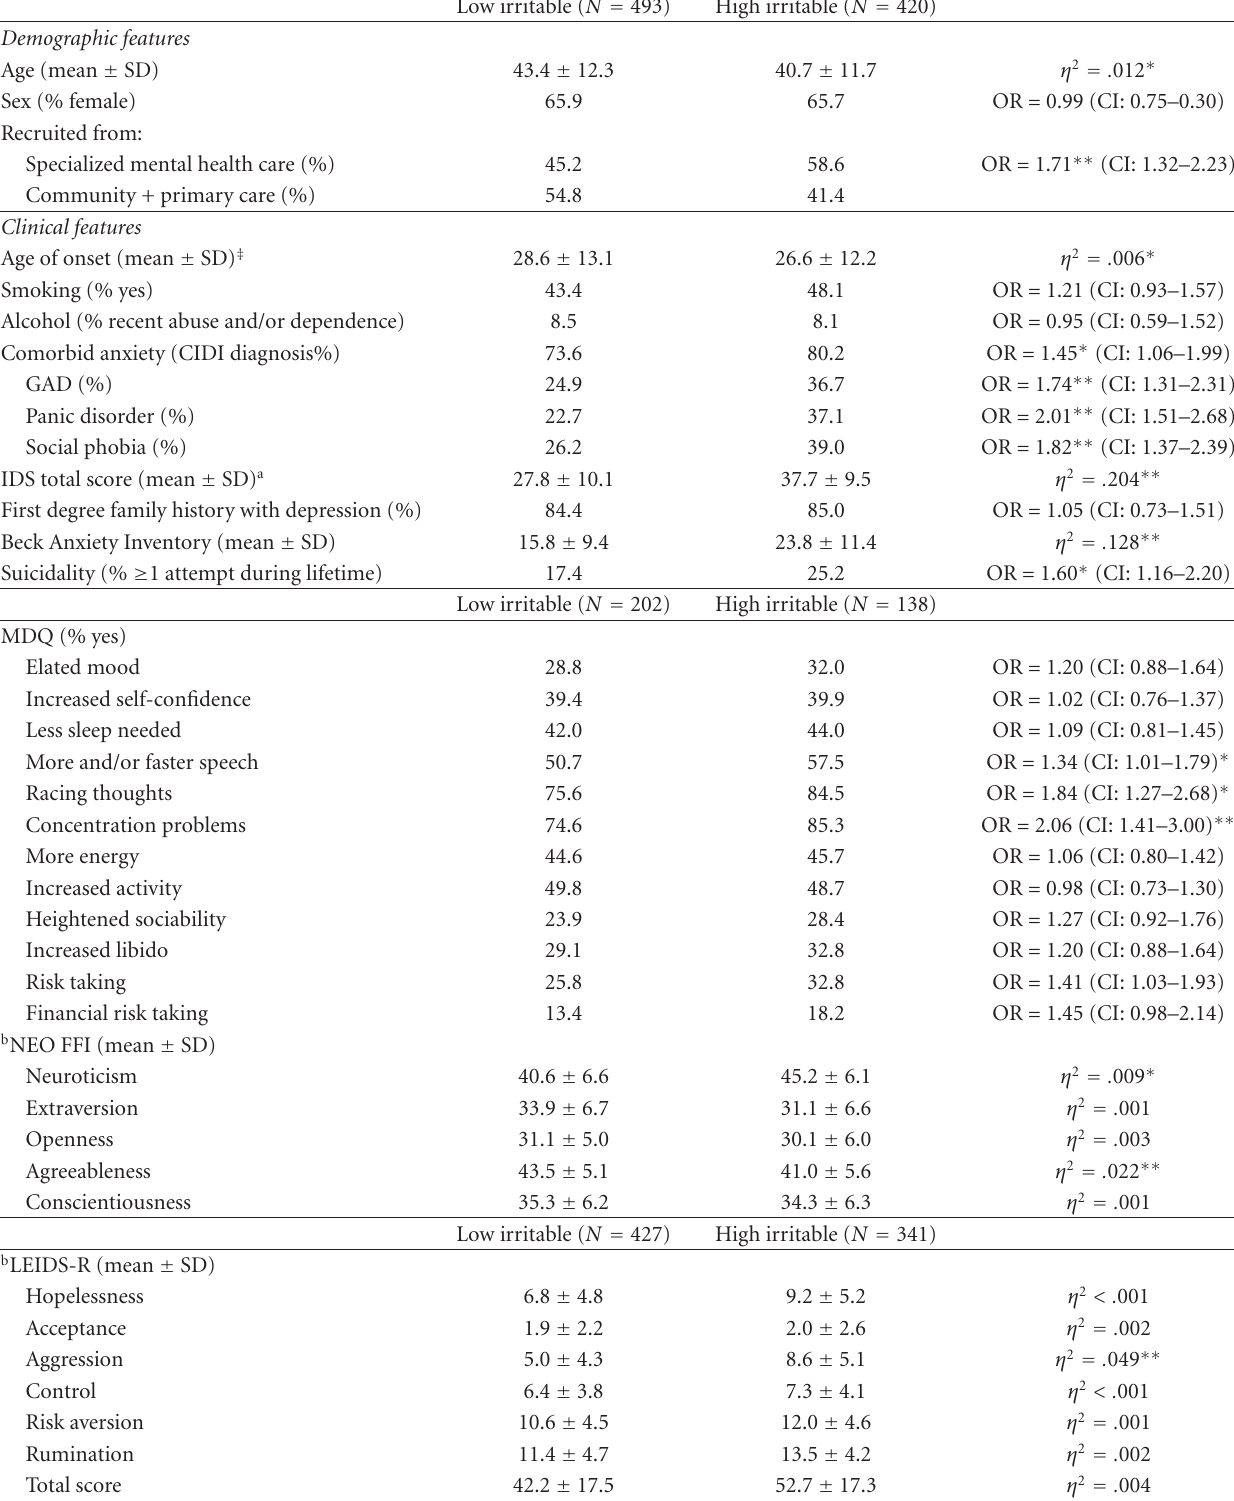
Table 1: Demographic and clinical characteristics of low and high irritable depressed patients: univariate